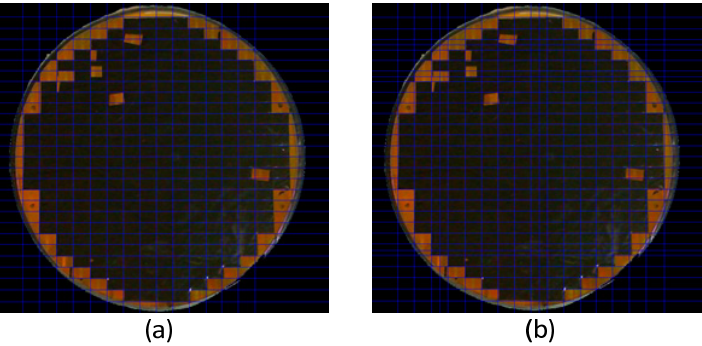
Figure 14. ( a ) The result of the peak detection method with a T value; ( b ) the result of the average line